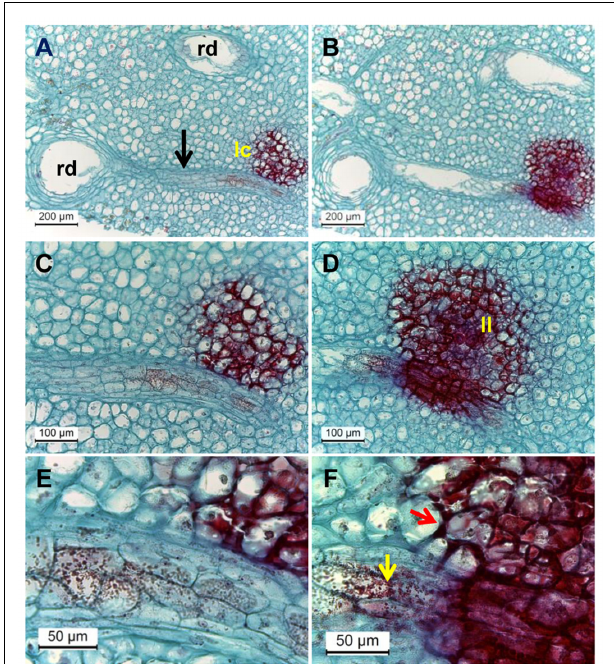
FIGURE 7 | Microscopic evaluation of resin duct contact with discolored lenticels in surface and deeper transverse histological sections of mango peel stained by safranin and fast-green after 3 weeks of cold storage. (A–F) Transverse sections of mango stored at 5 ◦ C, observed at various magnifications ( A, B , magnification × 100; C, D , magnification × 200; E, F , magnification × 400) showing discolored lenticels with phenolic accumulation (stained in red) and lenticel connection to resin duct. Dense red-colored granules are seen inside the resin duct. (B , D,F) Are surface cuts and (A , C,E) are deeper cuts. rd, resin duct; lc, lenticel; black arrow, zone of mesophyll cells seen between rd and lc; yellow and red arrows, phenolic transport and accumulation,